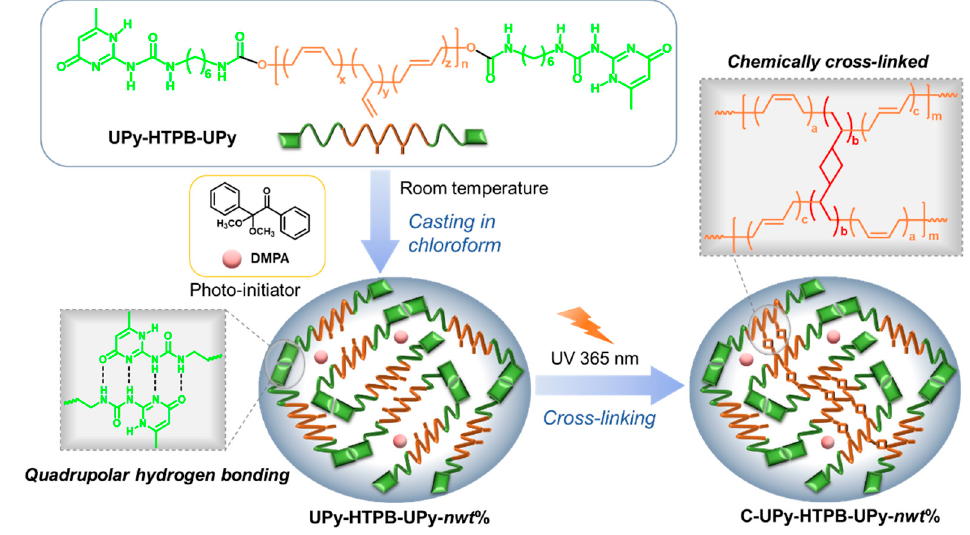
Figure 1. Material preparation procedure ( n represents the mass fraction of